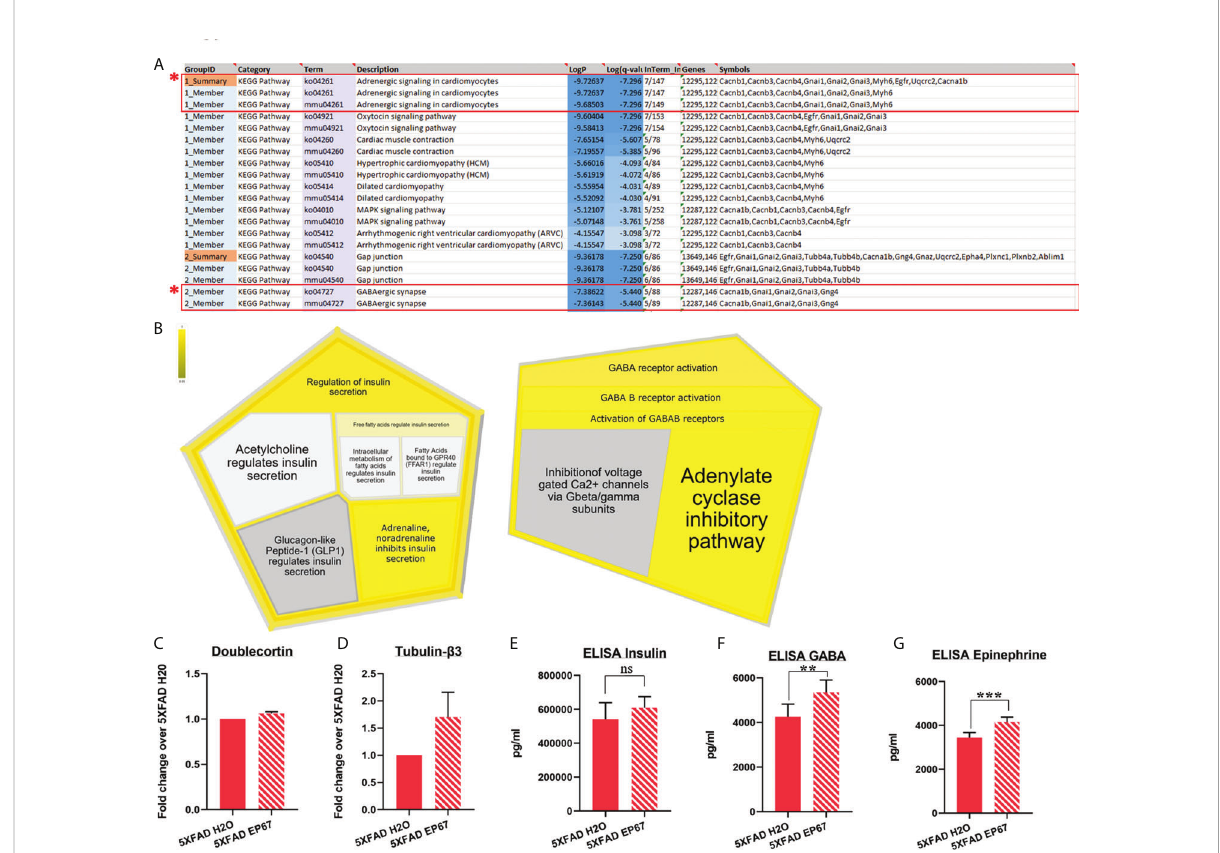
FIGURE 3 Proteomic analysis implicating b -adrenergic and GABAergic signaling on AD-related cognitive impairment. (A, B) Pathway enrichment analysis identifying two major signaling pathways involved with memory consolidation (highlighted), using the Metascape tool (A) and the Reactome online database (5XFAD, n = 6; 5XFAD EP67, n = 6) (B) . (C, D) RT-qPCR in 5XFAD- and 5XFAD EP67-treated animals ( n = 3 both groups); transcript levels represent average fold change of treated animals over their controls ( n = 3, mean ± SEM). (C) Unchanged levels of the nascent neuronal cell marker, doublecortin, and non-signi fi cant increase in the neuron speci fi c Tubulin- b 3 (D) . (E – G) Whole hemisphere brain homogenates from 5XFAD and 5XFAD mice treated with EP67 ( via ELISA) were used to measure the amount of insulin (E) , GABA (F) , and epinephrine (G) , which were found to be increased following treatment with EP67 apart from insulin, which remained unchanged. 5XFAD, n = 7; 5XFAD EP67, n = 9; mean ± SD. **P value ≤ 0.01, ***P value ≤ 0.001; ns, Not Signi fi